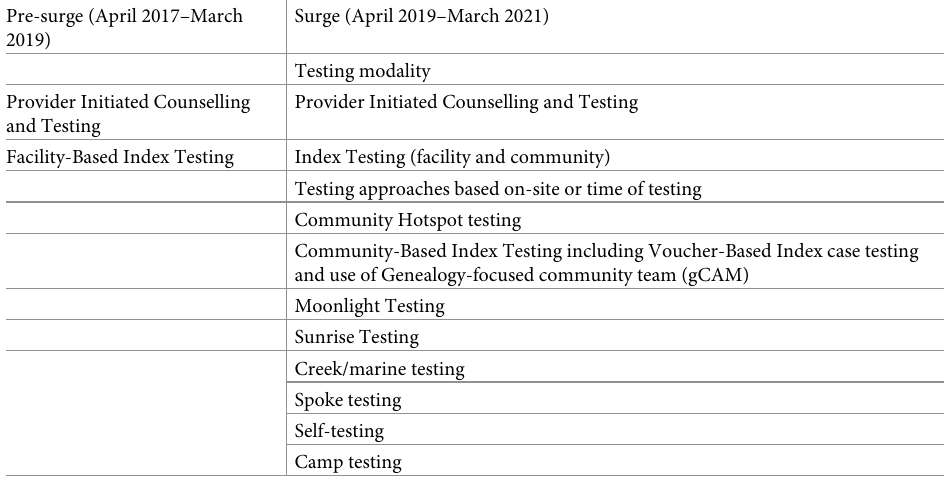
Table 2. HIV case-finding strategies and approaches used during the pre-surge and surge